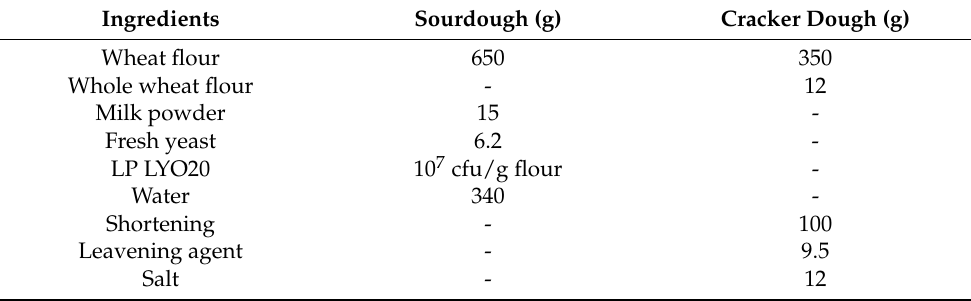
Table A1. Ingredients of the fermented